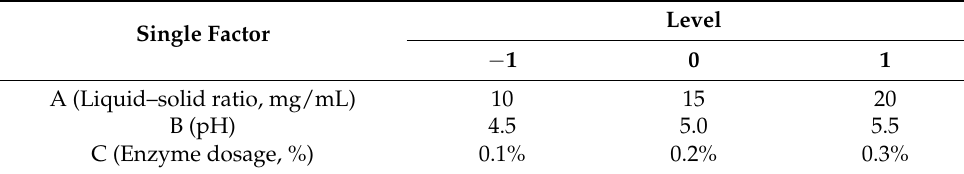
Table 1. Response surface test factors and levels.